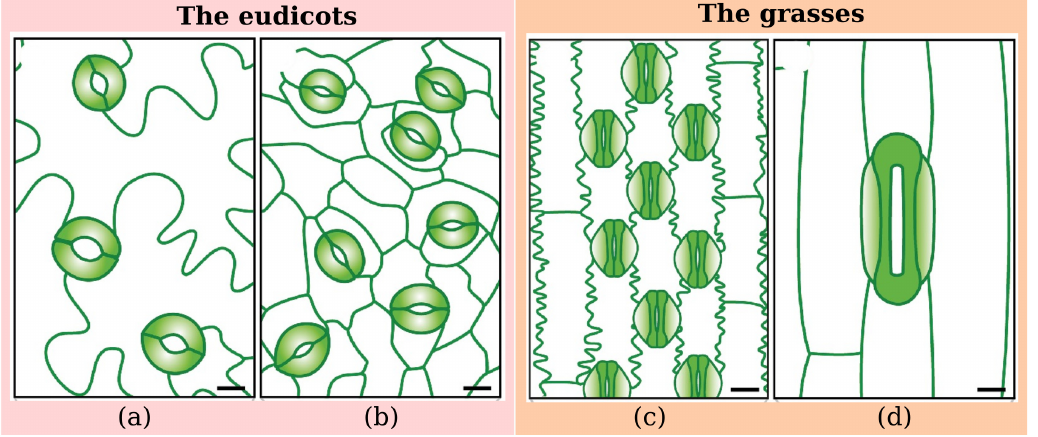
Fig 1. Variation of stomatal traits in terms of size and density from four different plant species: The eudicots are (a) Arabidopsis thaliana and (b) Phaseolus vulgaris ; The grasses are (c) Oryza sativa and (d) Triticum aestivum . Image adapted from [8].